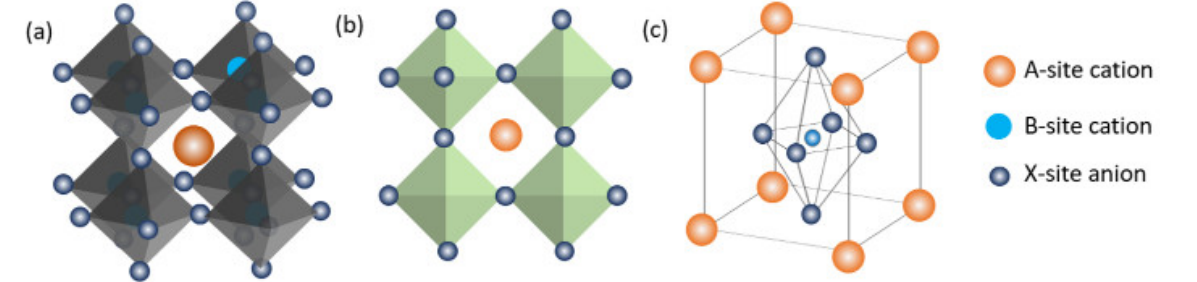
Figure 5. ( a ) 3D and ( b ) 2D schematic diagrams and ( c ) the schematic diagram of a perovskite unit cell [116].